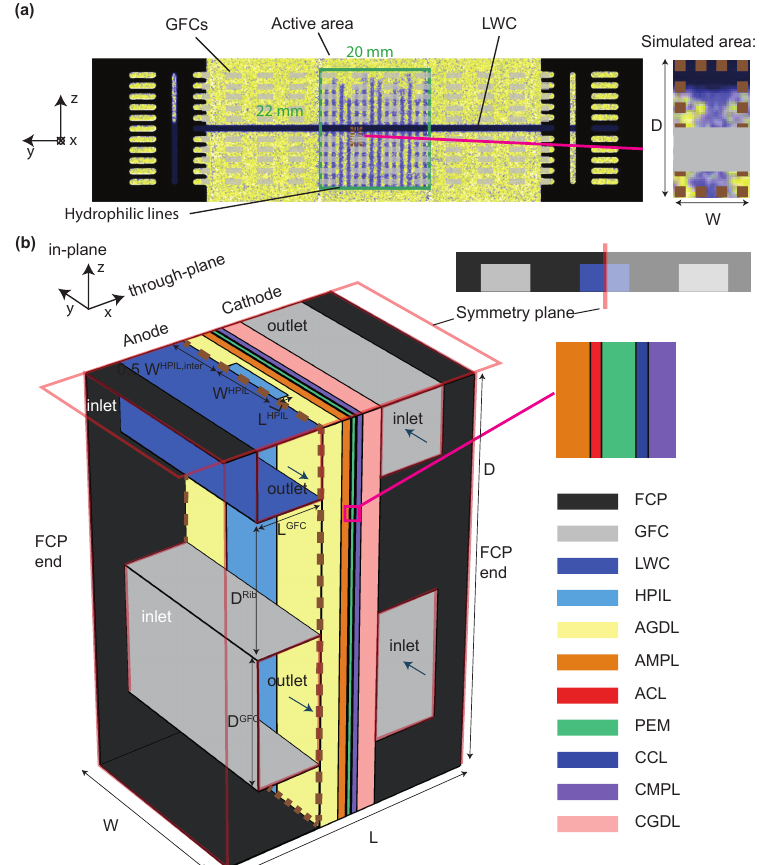
Figure 1. Experimental and numerical model setup. ( a ) Neutron radiography image of the experi- mental setup of [10] with the view on the top of the anode gas diffusion layer (AGDL), illuminating the presence of water in the hydrophilic lines (HPILs) and central liquid water channel (LWC). The brown dashed rectangle (zoom) indicates the part of this experiment that is represented by the numerical model. ( b ) Numerical model setup with in-plane width W = 1.48mm in direction of the gas flow channel (GFC), in-plane thickness D = 3mm in direction of the HPIL, through-plane thickness L = 2.428mm. Symmetry plane is indicated. The GFCs and LWC have a dimension of length L GFC = 500 µ m, thickness D GFC = 1mm with rib thickness D Rib = 1mm. The HPIL is characterized by a length L HPIL of 90 µ m and width W HPIL of 500 µ m. Two lines are separated by W HPIL,inter = 930 µ m. Dashed brown frame corresponds to the brown rectangle in ( a ). Direction of flow in the GFCs and LWC is indicated with blue arrows. Important model boundaries are highlighted via red